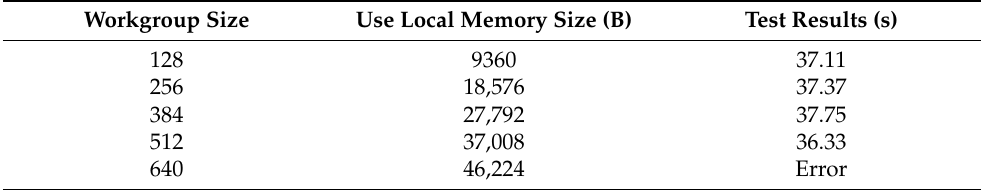
Table 4. Comparison test results of different workgroup sizes under the NVIDIA